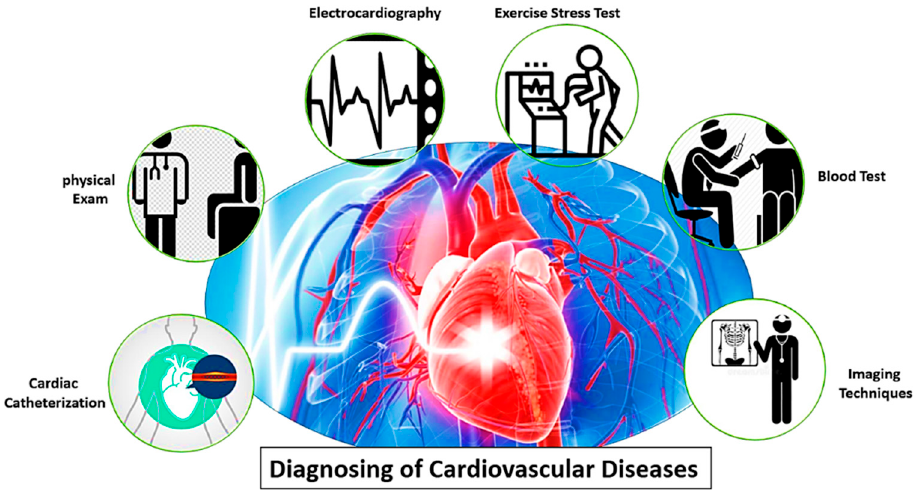
Figure 2. Current diagnosis techniques for CVDs.